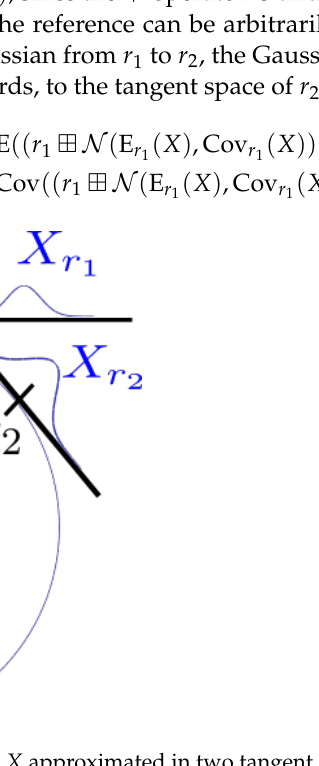
Figure 1. The Gaussian distribution X approximated in two tangent spaces on a unit circle manifold. As usual, no general closed form solution exists, since the operators are